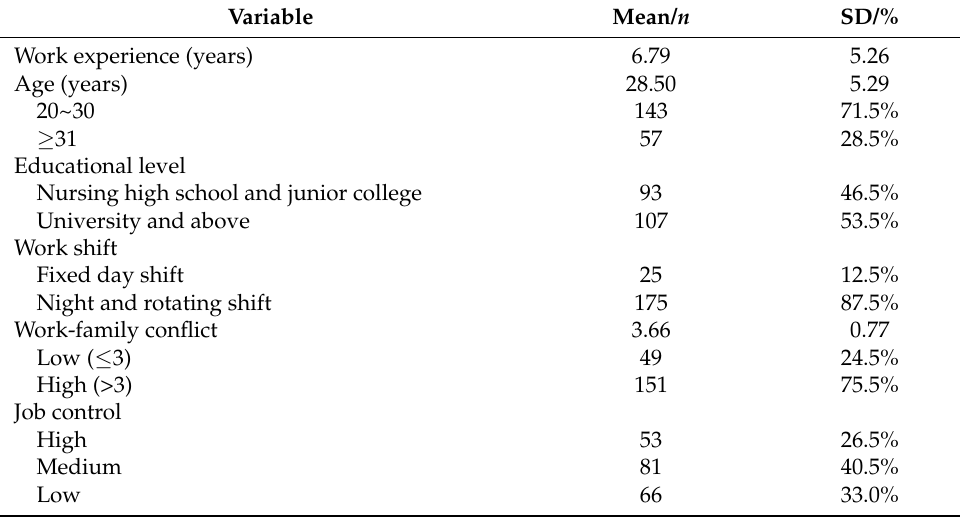
Table 1. Demographic characteristics of study participants ( N =